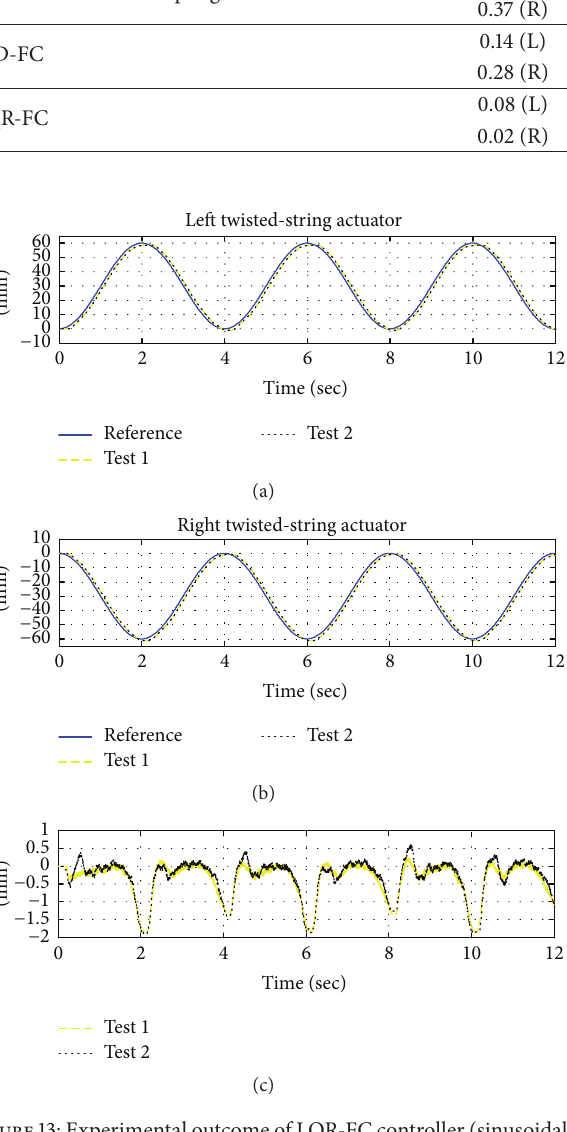
Figure 13: Experimental outcome of LQR-FC controller (sinusoidal motion): (a) comparison between reference trajectory and actual trajectories of left actuator; (b) comparison between reference tra- jectory and actual trajectories of right actuator; (c) synchronization errors between left and right actuators.